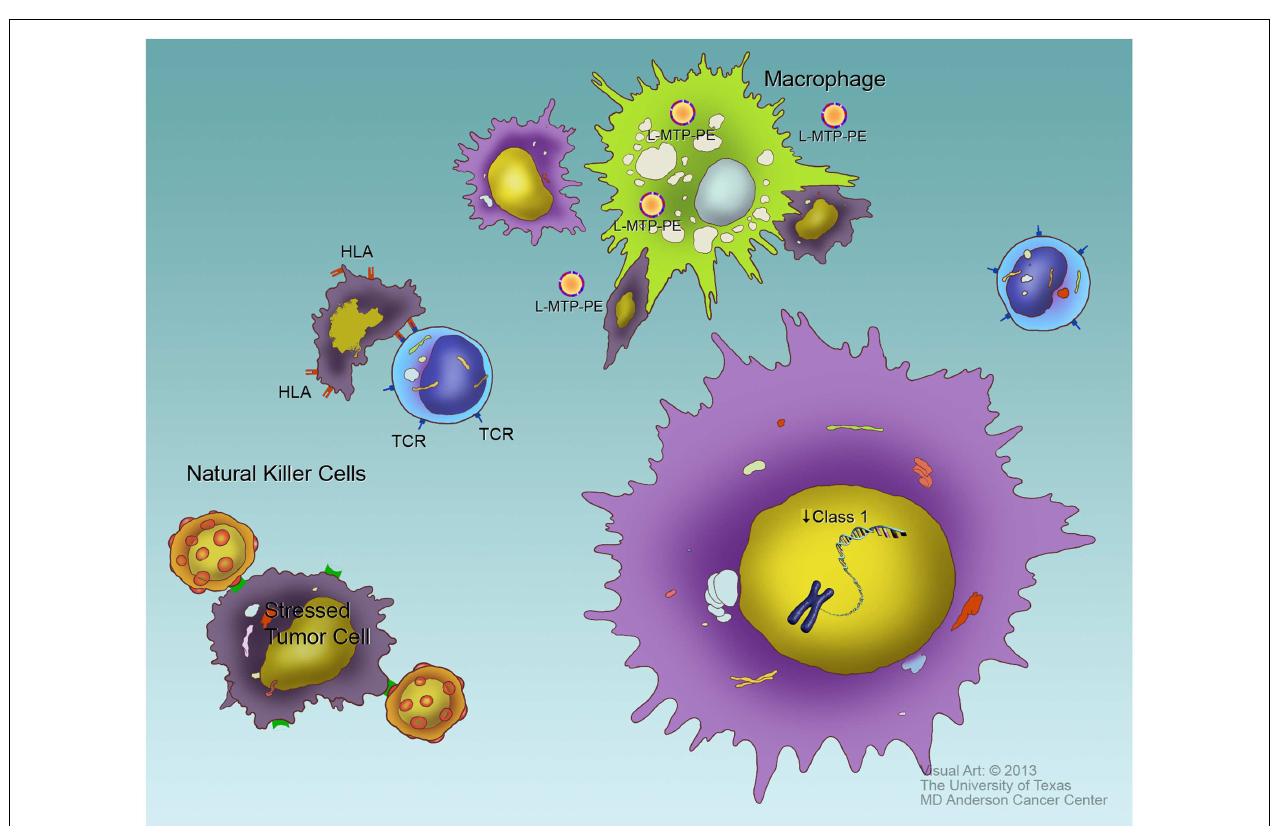
of self-HLA, so the down-regulation of HLA that allows tumors to evade cytotoxicT cells may facilitate their recognition by NK cells. Macrophages may ingest and destroy tumor cells in an antigen non-specific manner, though this process may require macrophage activation such as typically occurs in the sites of infection.The macrophage-activating drug L-MTP-PE has been shown to induce macrophage activation (top of figure) and improves survival in high-risk osteosarcoma patients when given in first complete remission or at a time of minimal residual disease, presumably by increasing phagocytosis on tumor